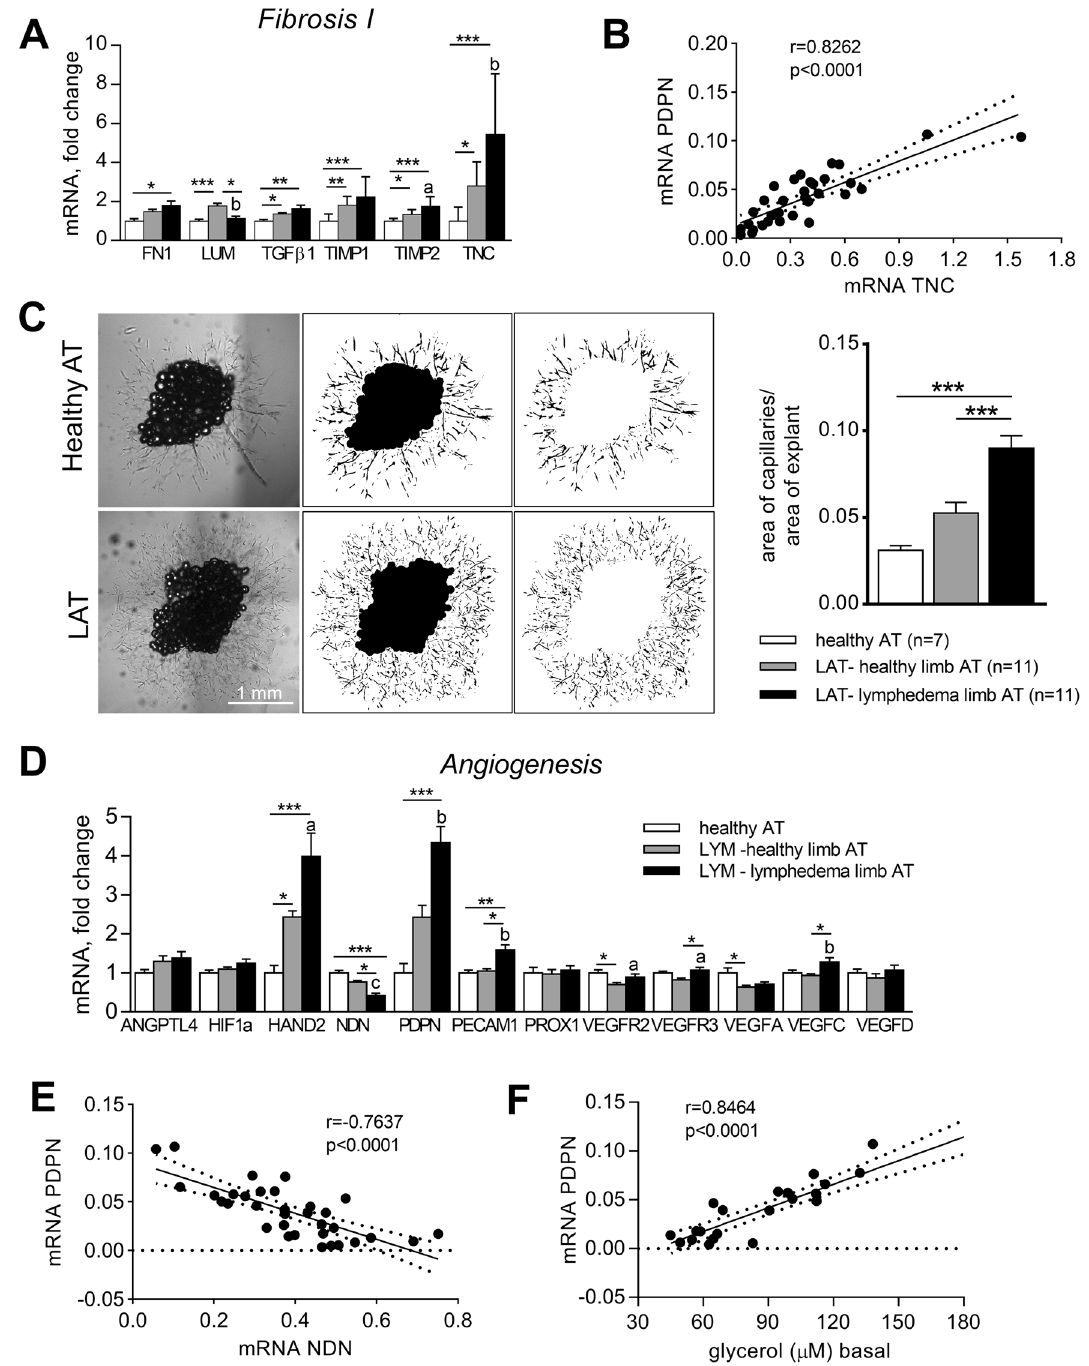
Figure 4. Fibrotic and angiogenic parameters of LAT. mRNA levels of fibrotic ( A ) and angiogenesis ( D ) markers for post-hoc analysis in whole AT expressed as fold change over the mean expression of healthy group (Kruskal–Wallis test of 2 ΔCt values, Dunn’s correction, comparison of 3 groups, *p < 0.05, **p < 0.01, ***p < 0.001; Wilcoxon test of paired healthy and diseased limb of LYM subjects, a- p < 0.05, b- p < 0.01, c- p<0.001). ( B , E ) Correlation of mRNA levels of PDPN with TNC ( B ) and NDN ( E ) in whole AT (Spearman correlation test). ( C ) Representative images of ex vivo angiogenic assay on AT explants with related image analysis (One way ANOVA of LN transformed data, Bonferroni correction for post-hoc analysis, comparison to diseased limb of LYM group, ***p < 0.001). ( F ) Correlation of mRNA PDPN with glycerol release in whole AT (Spearman correlation